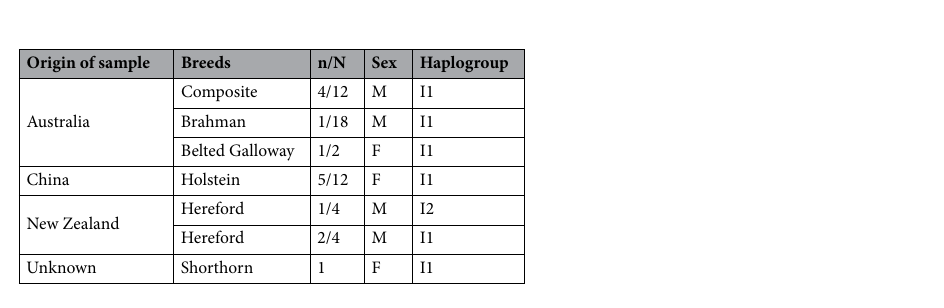
Table 4. Prevalence of indicine haplogroup (I) in European taurine breeds and composites. F female, M male, U unknown, n no. of animals showing I haplogroup, N no. of animals in a breed sampled in a country.